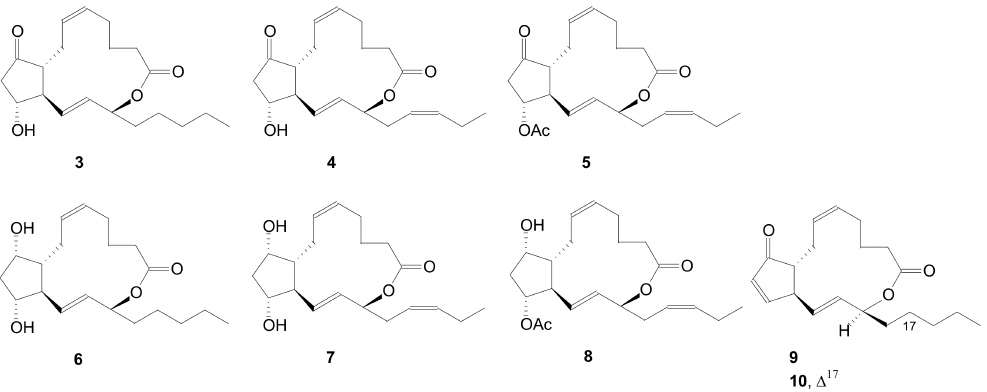
Figure 2. Prostaglandin 1,15-lactones found in mollusc Tethys fimbria